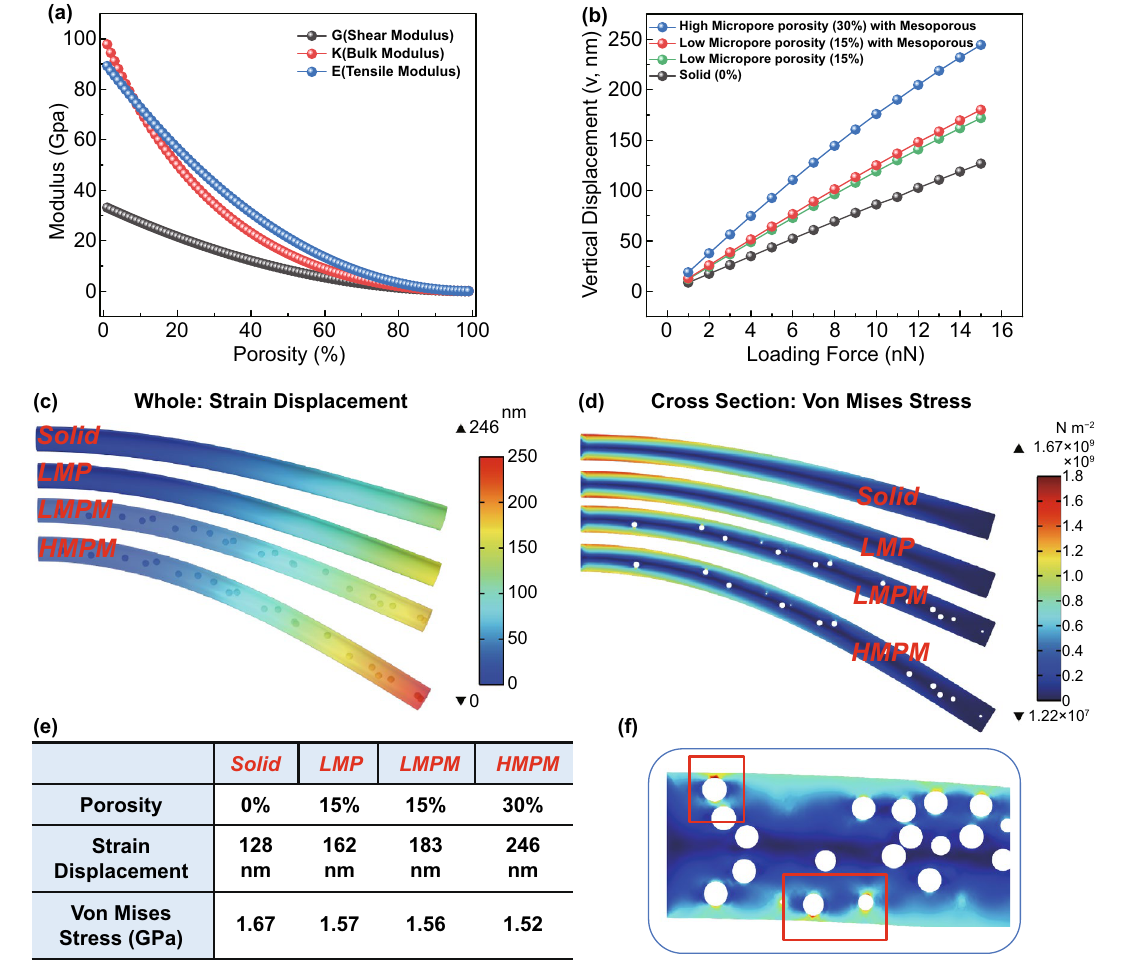
Fig. 1 a The corresponding reference values of shear modulus, volume modulus, and elastic modulus under different porosities when the Pois- son’s ratio of raw materials is 0.35. b Vertical stress displacement of non-porous fiber (solid), low microporous fiber (LMP), low microporous fiber with mesoporous interior fiber (LMPM) and high microporous fiber with mesoporous interior fiber (HMPM) under different loading forces. When the loading force is 15 nN, the overall displacement diagram of solid, LMP, LMPM, and HMPM ( c) , the sectional stress distribution ( d) , and the specific parameter table ( e) are presented. f Simulation model picture of stress singularity when excess mesoporous is located on the fiber